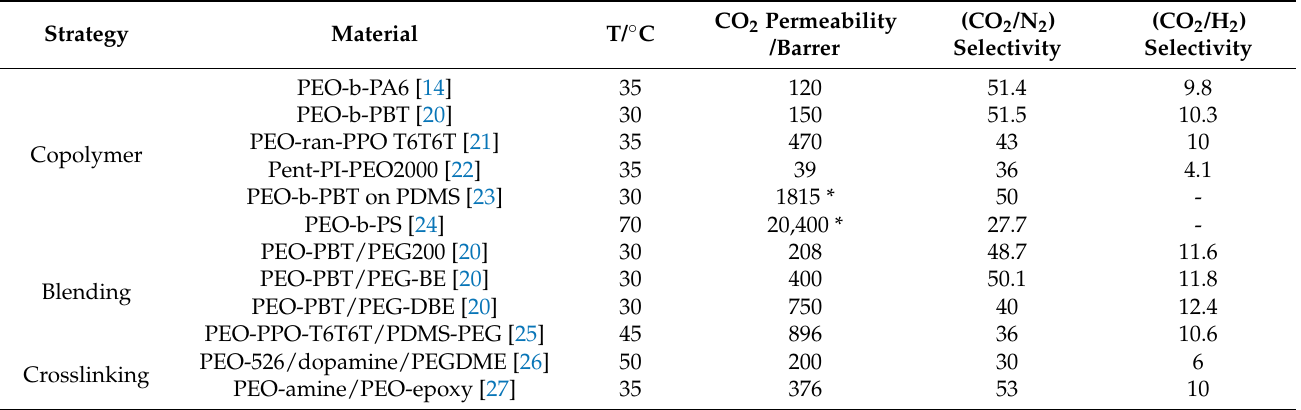
Table 2. Transport properties of specific PEO